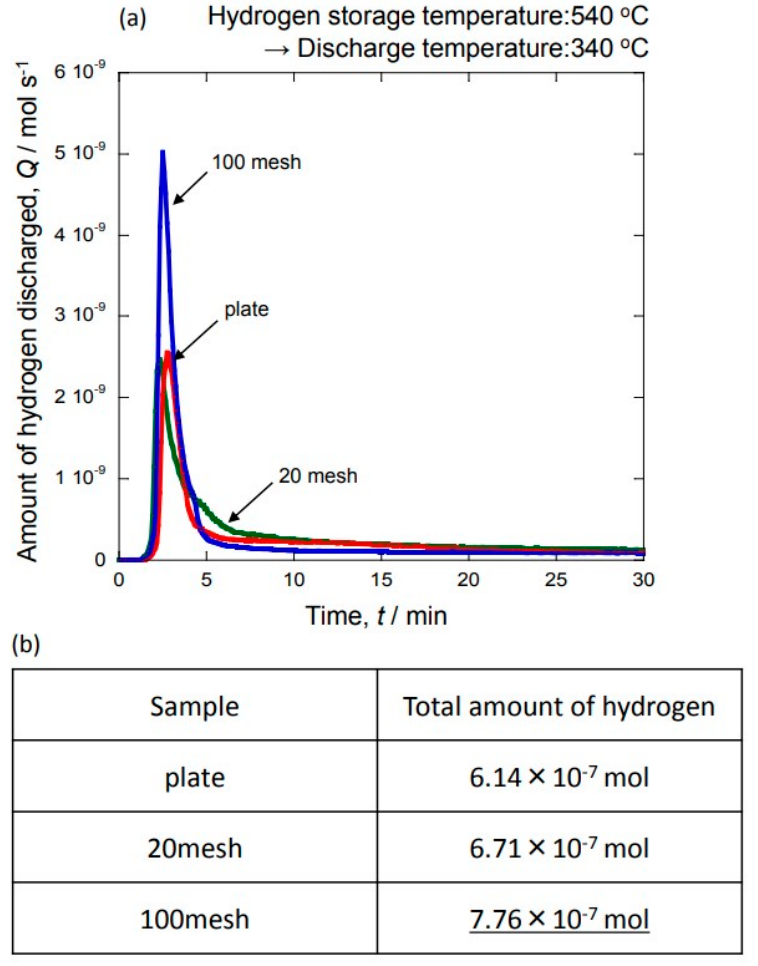
Figure 12. Amount of hydrogen discharged ( a ) and total amount of hydrogen ( b ) of Ni plate and Ni mesh after La deposition in NaCl-KCl-5.0 mol%LaF 3 melts at 750 °C.